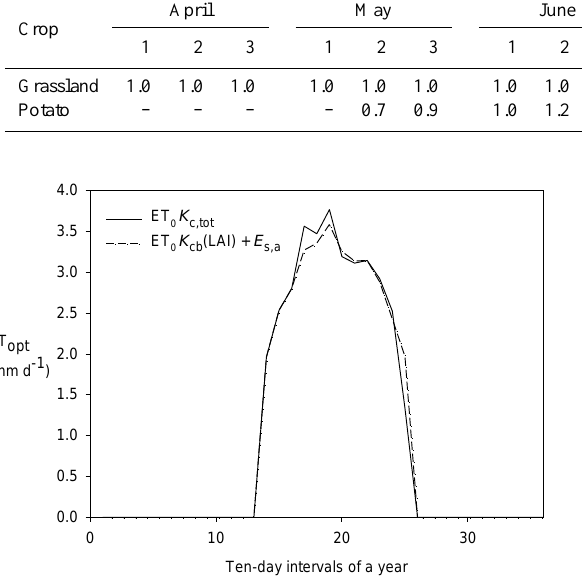
Figure B3. Partitioning of cumulative total evapotranspiration of unstressed potato (ET opt ) per 2 Fig. B3. Partitioning of cumulative total evapotranspiration of un- opt ) cal- stressed potato (ET opt ) per ten-day interval, averaged over 30yr ten-day interval, averaged over 30 years (1971-2000); E s,a – actual soil evaporation, T p – 3 (1971–2000); E s,a – actual soil evaporation, T p – potential crop potential crop transpiration, E i – canopy interception evaporation. 4 transpiration, E i – canopy interception